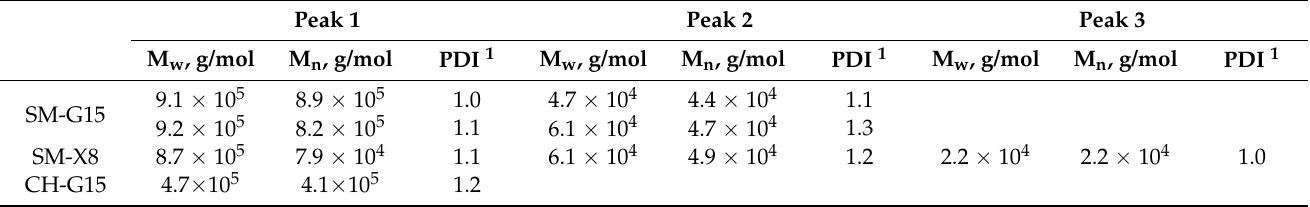
Table 5. Molecular weight of the EPS produced by cultivation of B. atrophaeus BU4 in xylose- (SM-X8) and glucose-based (SM-G15) synthetic media and in a quinoa stalk cellulosic hydrolysate (CH-G15). Peak 1 Peak 2 Peak